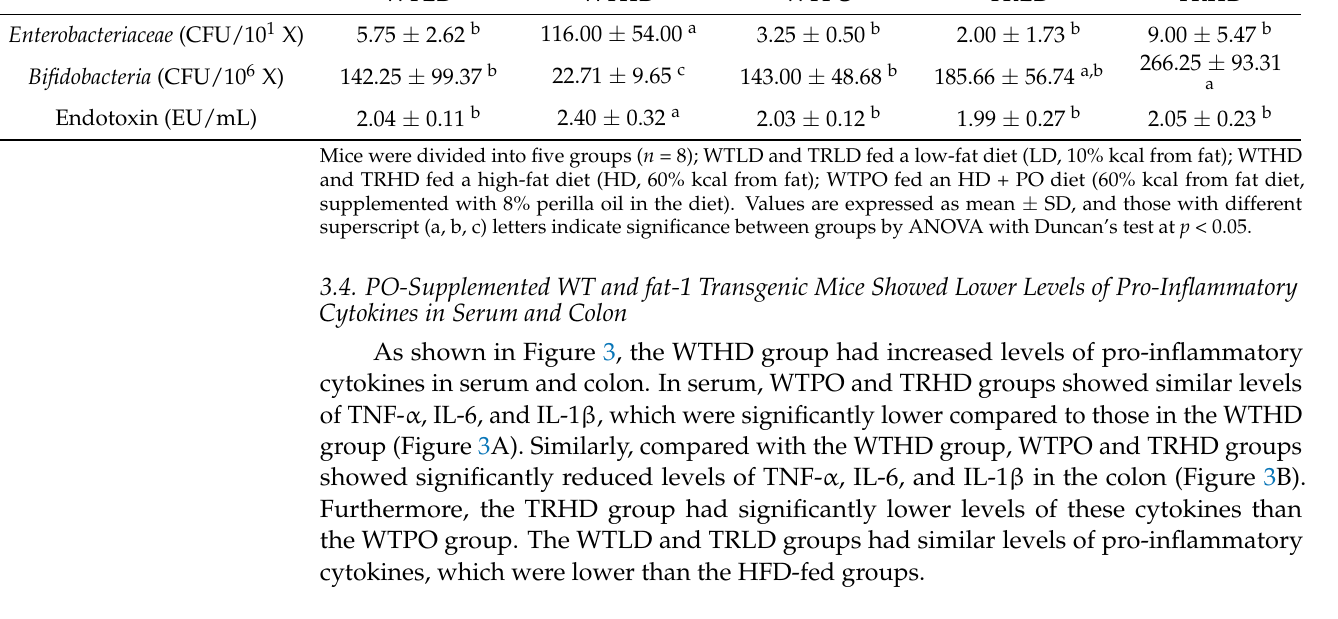
Table 4. Fecal count of Enterobacteriaceae , Bifidobacteria , and endotoxin levels in serum. WTLD WTHD WTPO